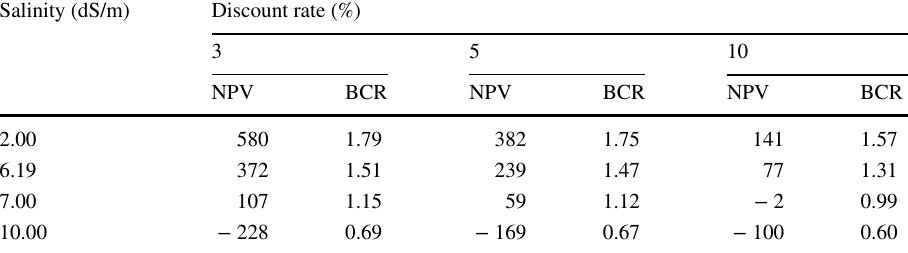
of date palm cultivation in million USD for Nablus District under various discount rates (3, 5, 10%) and salinity levels